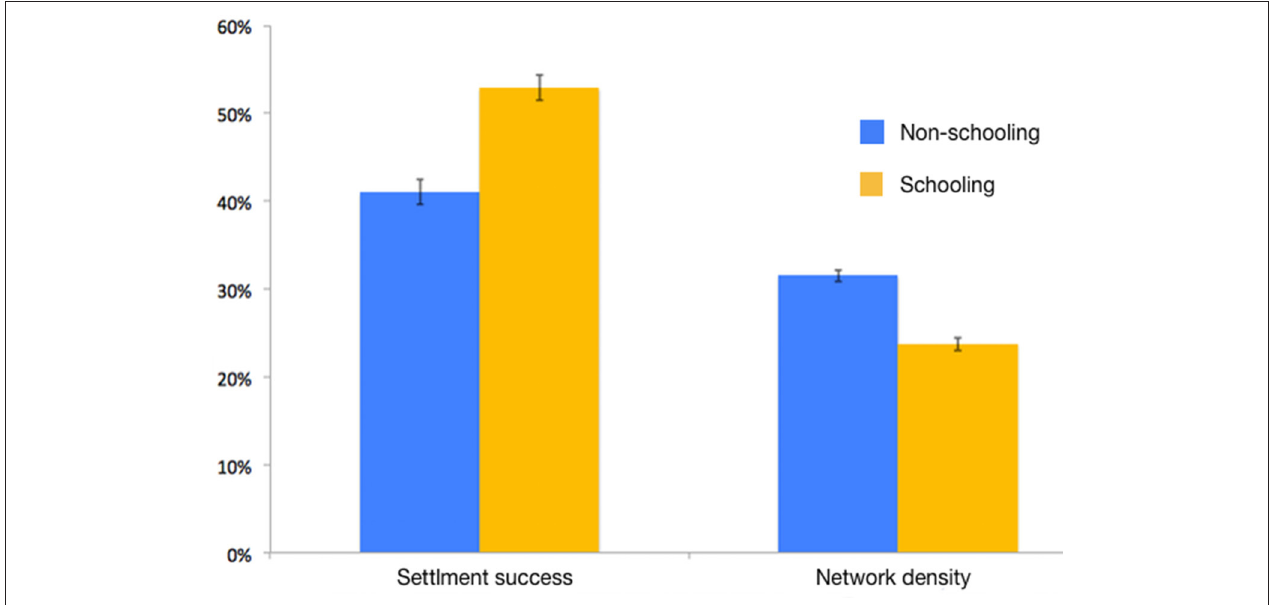
FIGURE 5 | Settlement success and connectivity network density (i.e., the percentage of realized connections out of all possible connections) of individual and schooling larvae (Sim. #5 vs. #8 in Table 1 ).